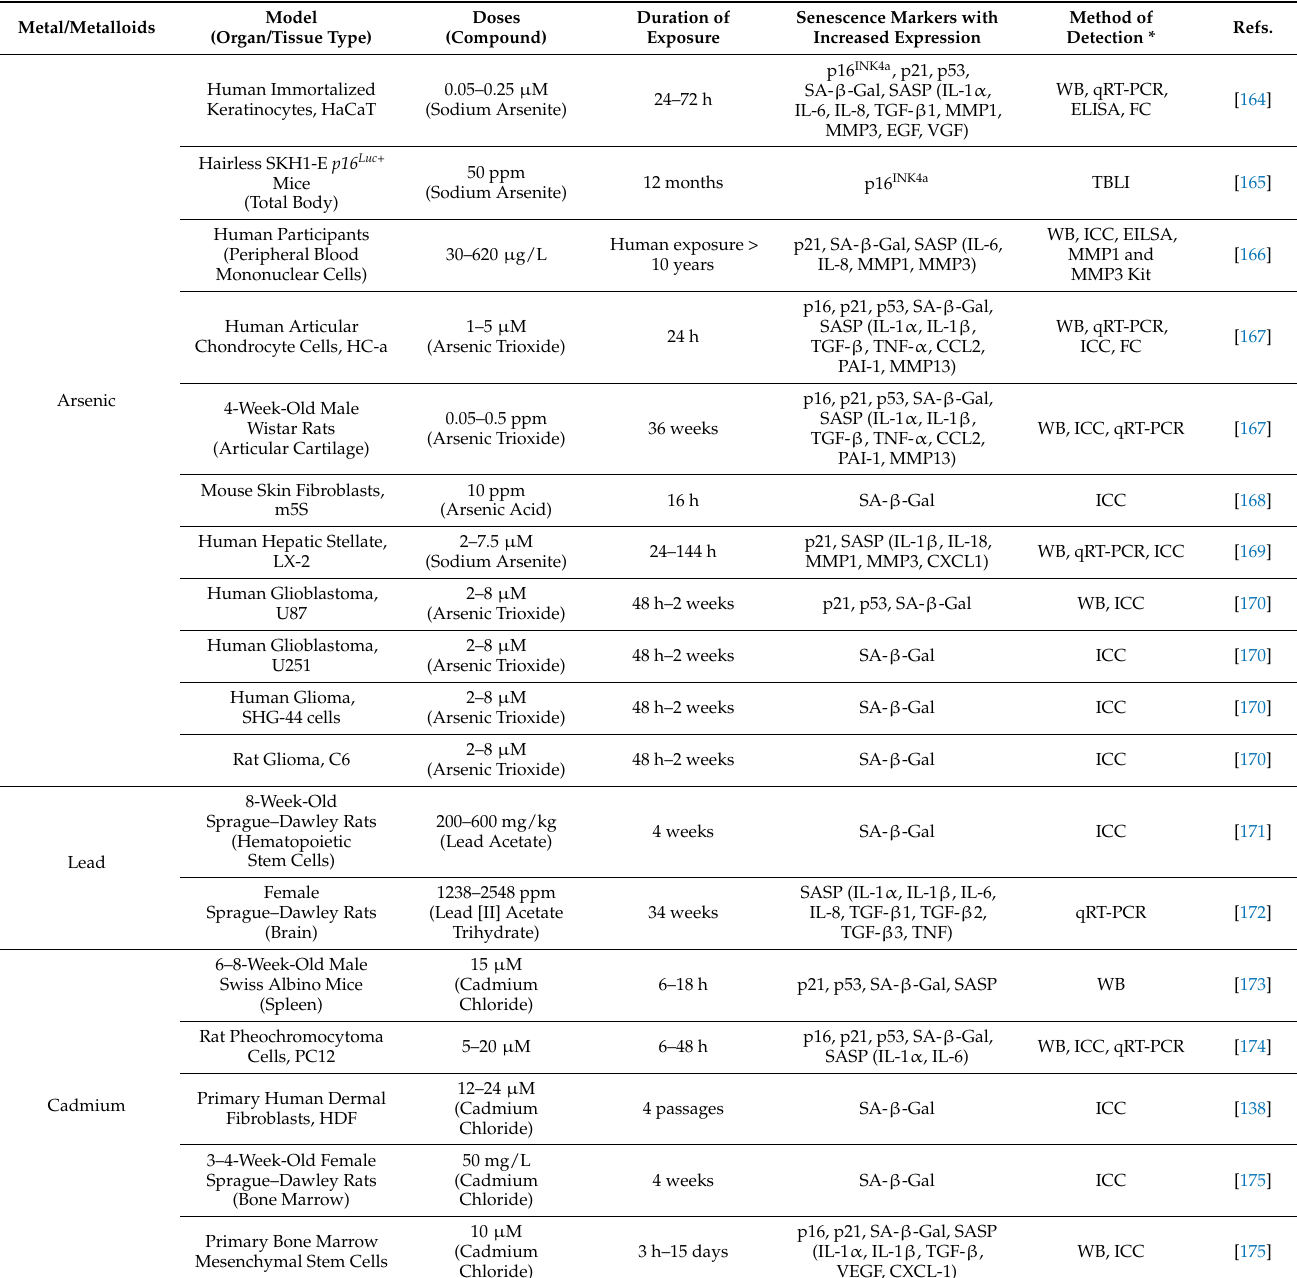
Table 2. Summary of Senescence Markers Increased After Heavy Metal of Metalloid